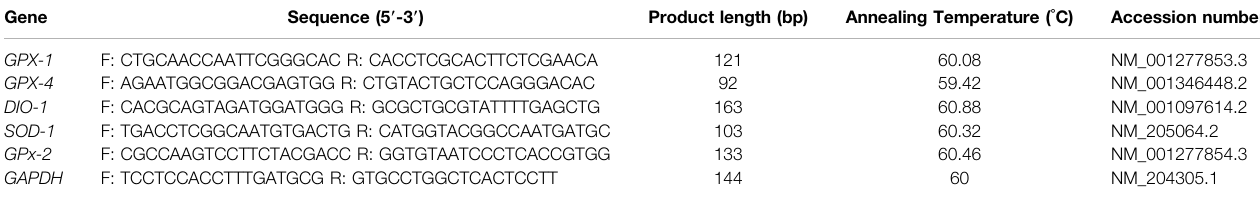
TABLE 2 | Primers used for quantitative real-time polymerase chain reaction (qRT-PCR). Gene